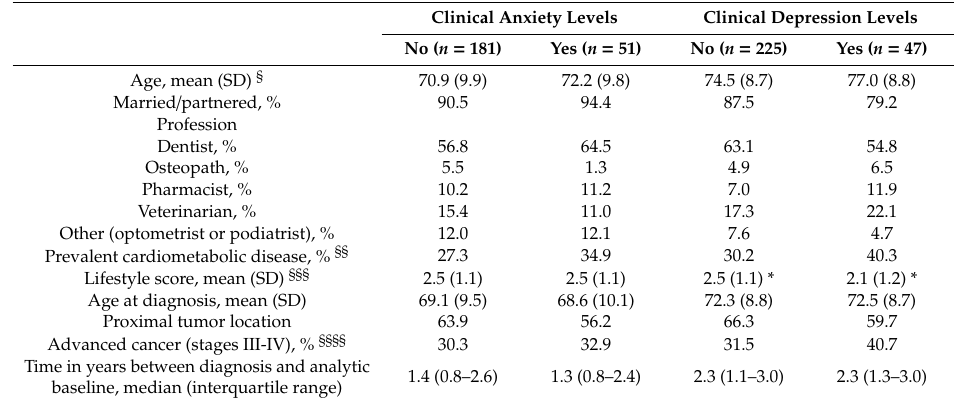
Table 2. Distribution of age-standardized characteristics of HPFS men within four years after CRC diagnosis by level of anxiety or